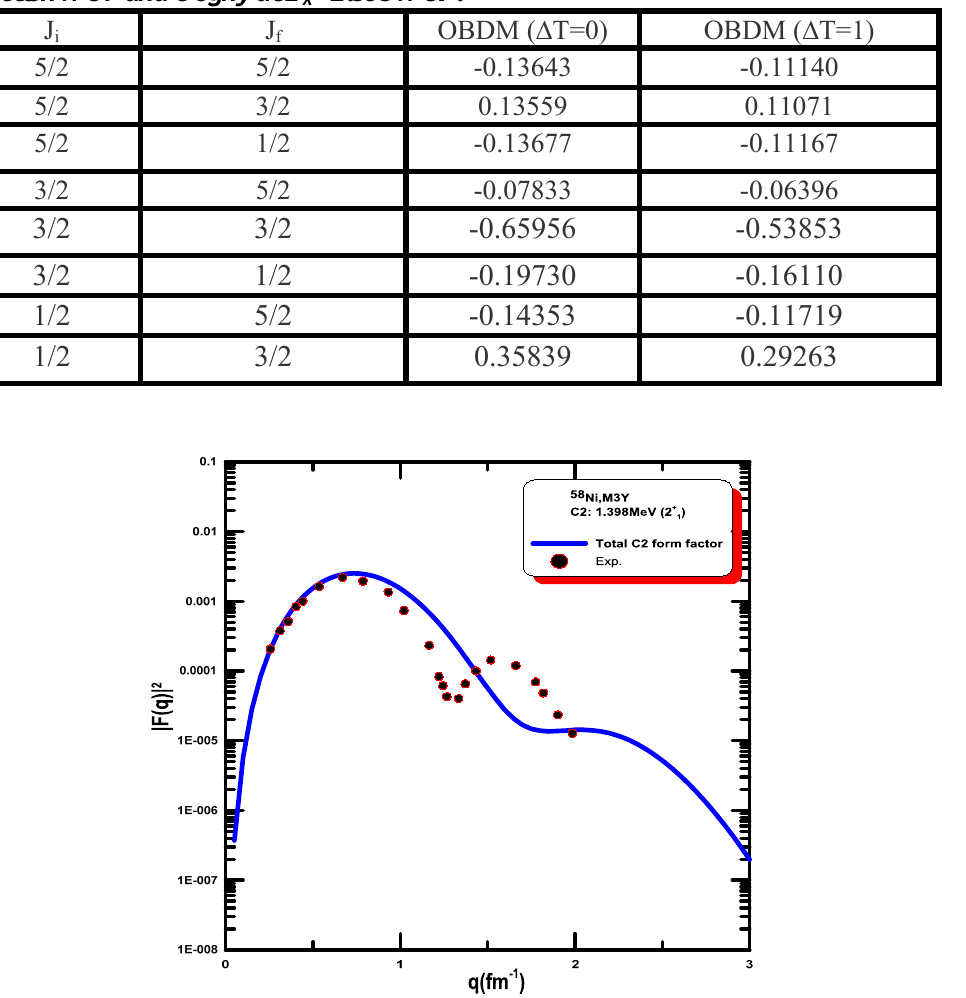
Fig.1: Inelastic longitudinal C2 form factors (total) for the (E with M3Y, theoretical data represented by solid curve, the experimental data (filled circles) are taken from Ref.